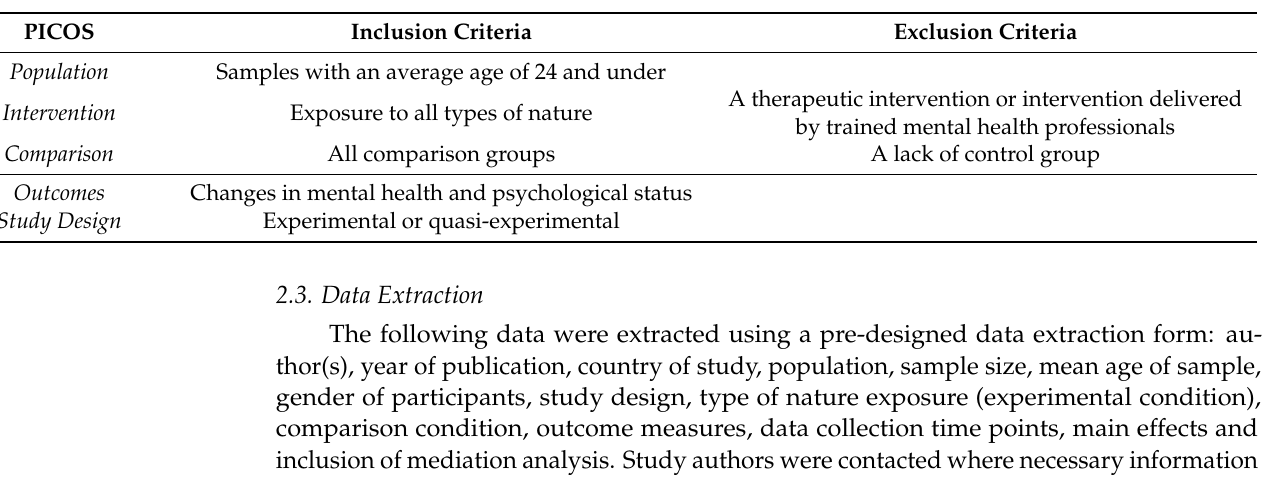
Table 2. Inclusion and Exclusion Criteria Based on the PICOs